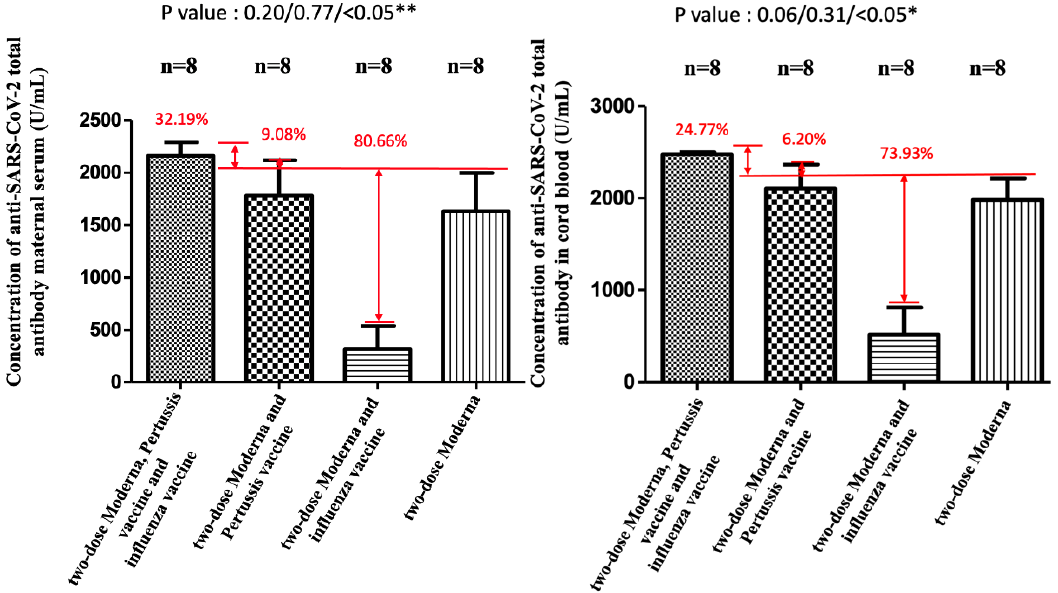
Vaccines 2023 , 11 , x FOR PEER REVIEW Figure 6. Quantitative measurement of anti-SARS-CoV-2 antibody in maternal and cord blood. ** and * both indicate statistically significant.